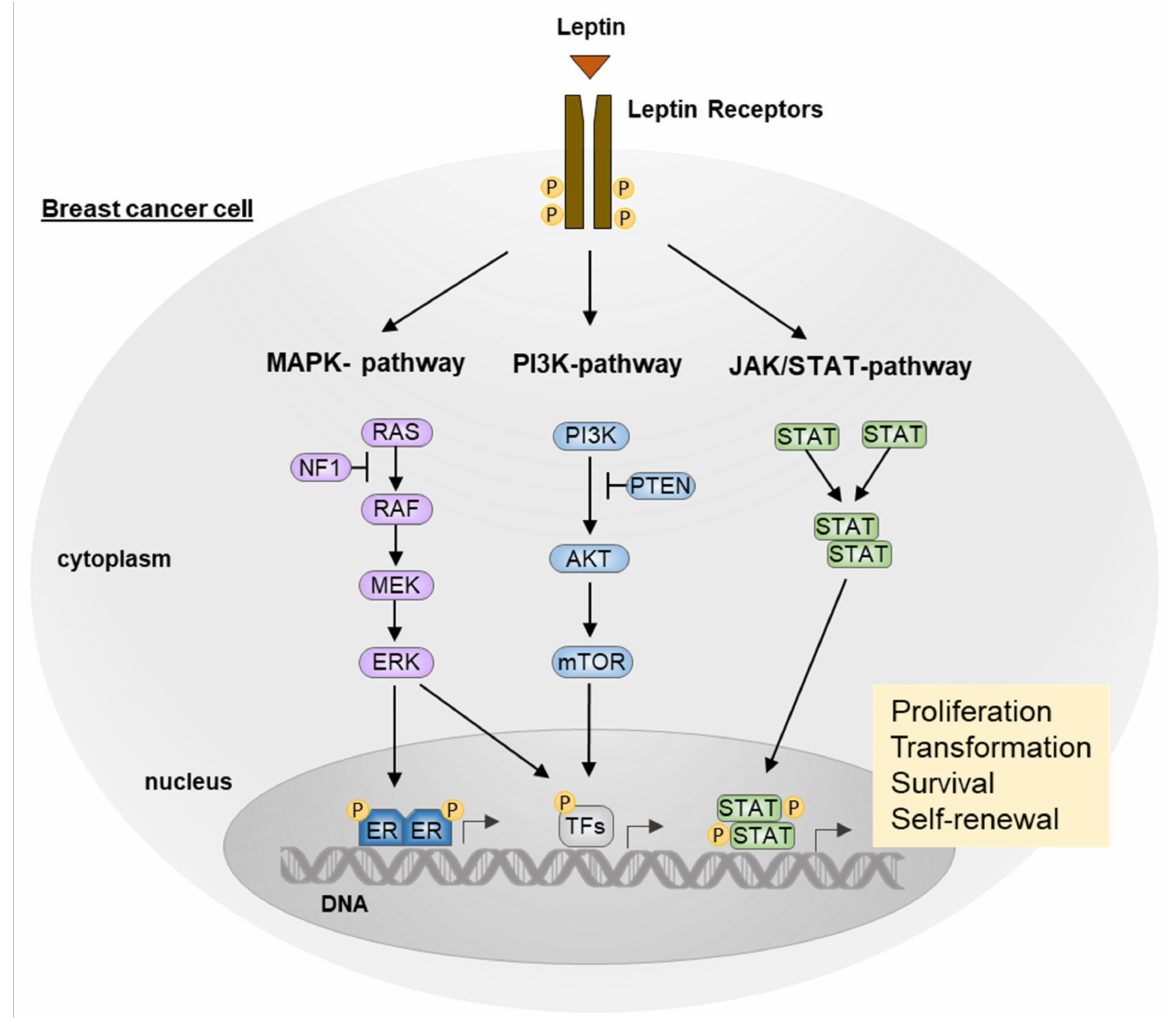
Figure 2. Leptin-induced oncogenic signaling pathways in breast cancer. Schematic representation of key intracellular signaling pathways associated with activation of leptin receptors upon binging with leptin in breast cancer cells. AKT, protein kinases; ER, estrogen receptor; PI3K, phosphatidylinositol 3-kinase; Ras, Rat sarcoma subfamily of GTPases; mTOR, mammalian target of rapamycin; MEK, mitogen-activated protein kinase; RAF, RAF kinase; JAK/STAT: Janus kinases/signal transducers and activators of transcription; PTEN, phosphatase and tensin homolog; TFs, transcription